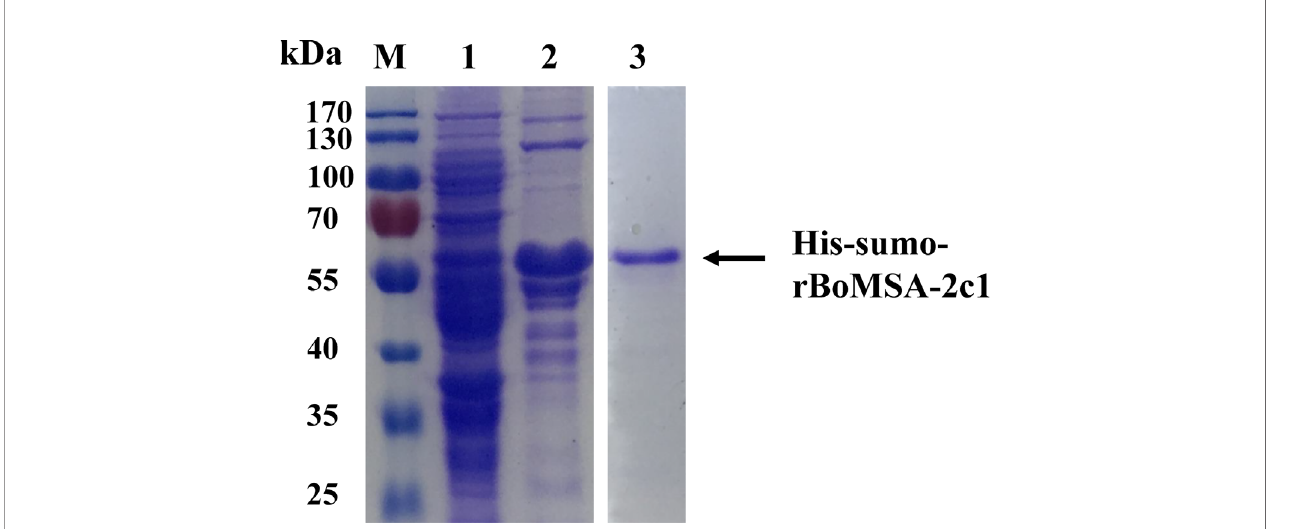
FIGURE 1 | Expression and puri fi cation of rBoMSA-2c1. Expression of rBoMSA-2c1 in E. coli BL21 (DE3) assessed by SDS-PAGE. Lysates of pE-sumo-BoMSA-2c1 without (lane 1) and with (lane 2) IPTG induction. Puri fi ed product of rBoMSA-2c1 (lane 3). Arrows indicate the corresponding bands. IPTG, isopropyl- b -d-